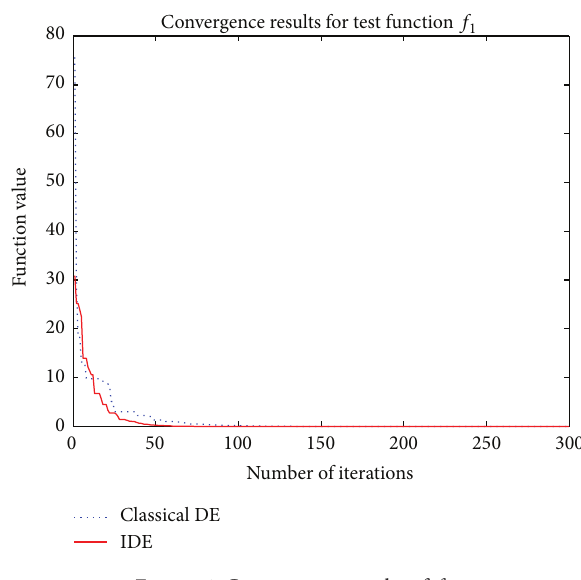
Figure 1: Convergence results of 𝑓 1